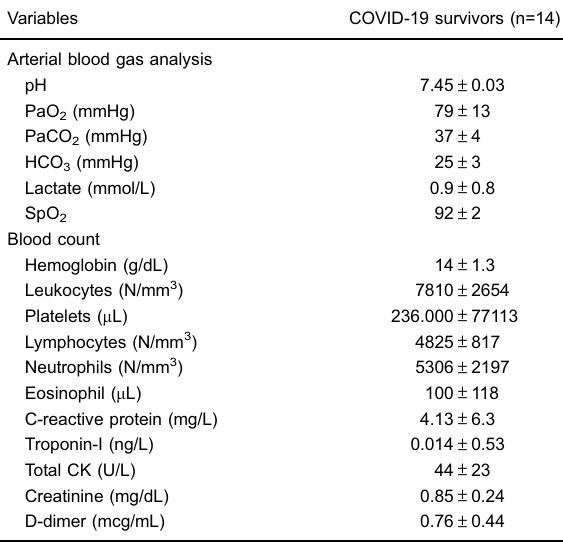
Table 3. Linear regression analysis to predict